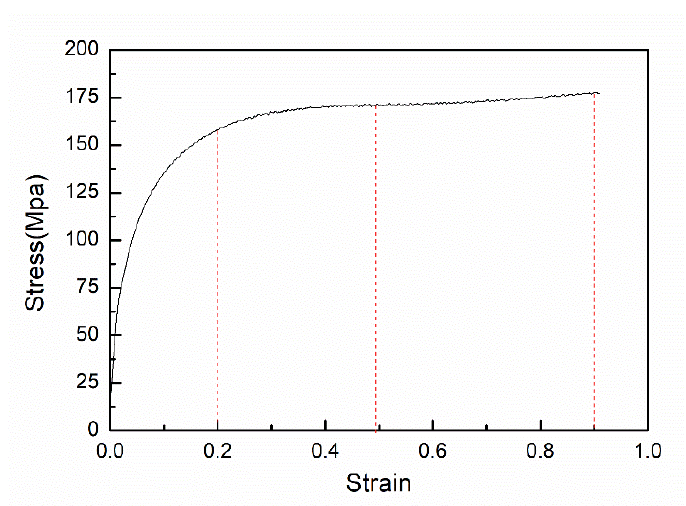
Figure 12. The true stress–strain curves for the low-carbon ferritic stainless steel samples with a deformation reduction of 0.9.